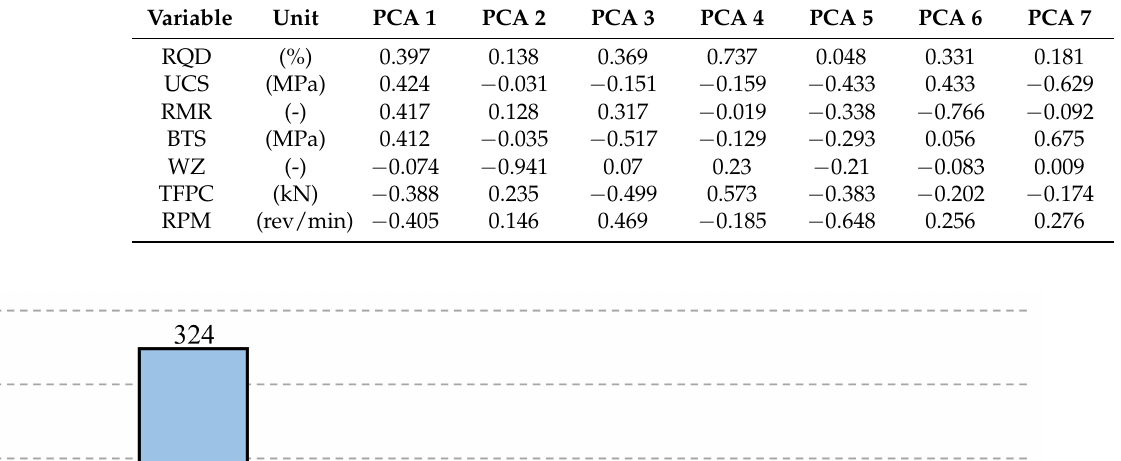
Table 4. Relationship between the principal components and input parameters.